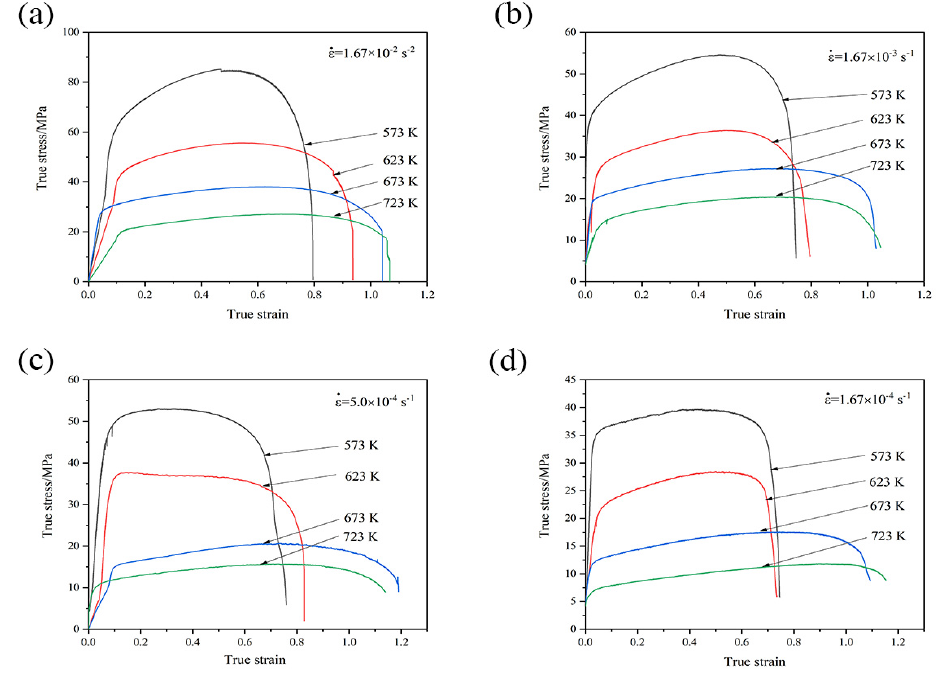
Figure 6. True stress–strain curves of GAZ211 alloy at different temperatures and initial strain rates: ( a ) 1.67 × 10 − 2 s − 1 ; ( b ) 1.67 × 10 − 3 s − 1 ; ( c ) 5.0 × 10 − 4 s − 1 ; ( d ) 1.67 × 10 − 4 s − 1 .